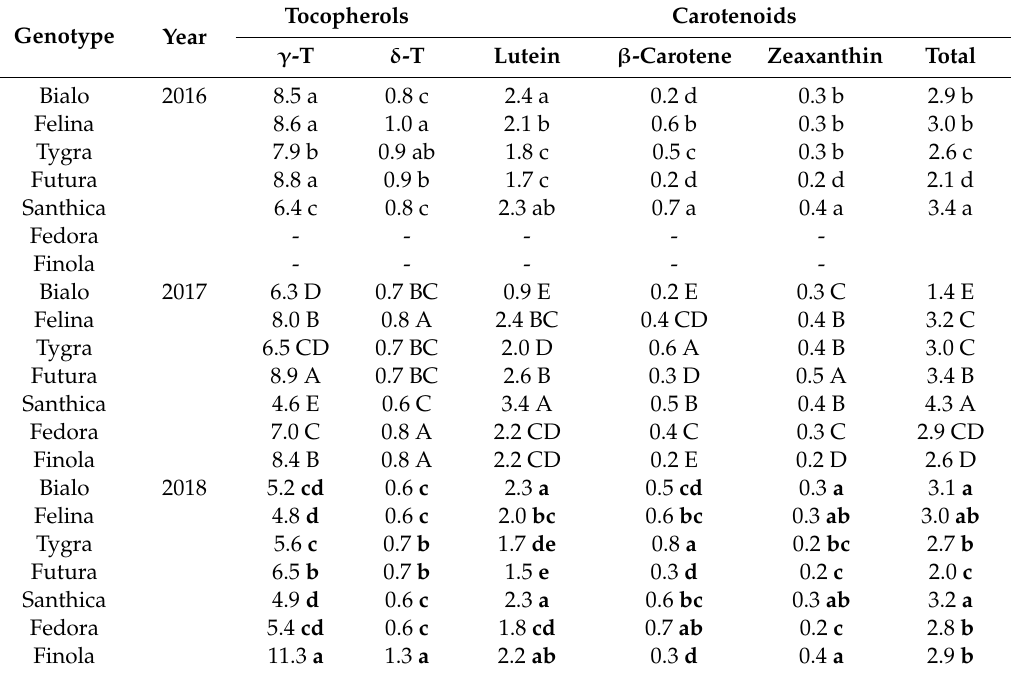
Table 5. Tocopherols and carotenoid contents (mg 100 g − 1 seed) of hemp seeds from the seven industrial hemp cultivars cultivated in this study and for three growing seasons (2016, 2017, and